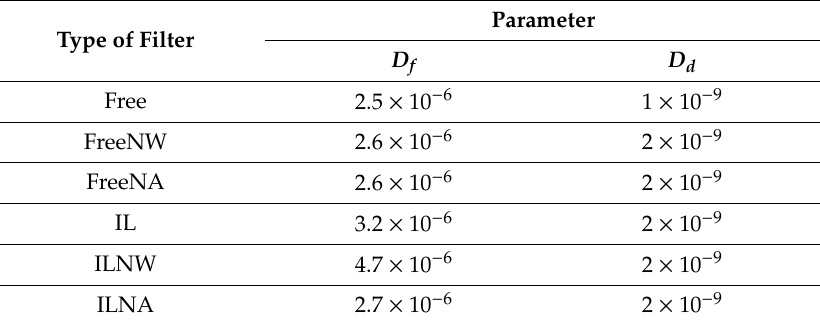
Table 3. Di ff usion and dispersion parameters as recovered from the simulations of the di ff erent types of filters. Values were found by trial and error to match the simulation results with the experimental data for